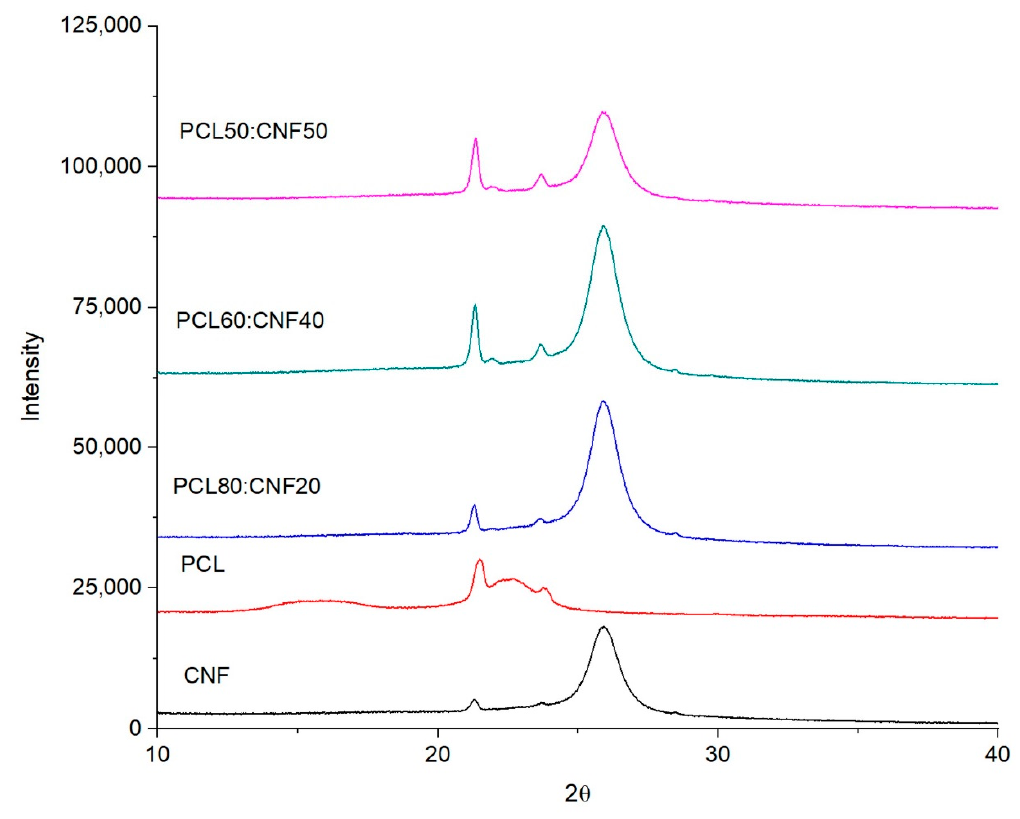
Figure 3. XRD spectra of cellulose nanofibers (CNF), polycaprolactone (PCL), and electro-spun membranes of 50:50, 60:40, and 80:20 PCL/CNF ( v / v ) ratios.